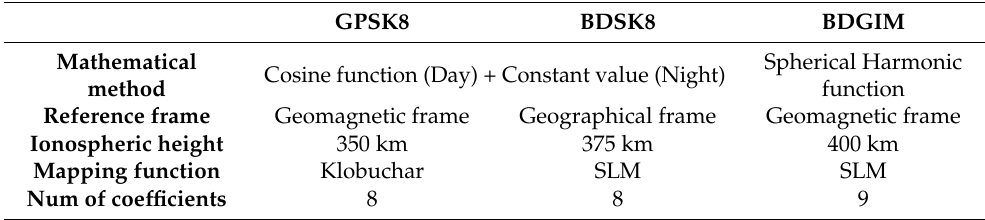
Spherical Harmonic function